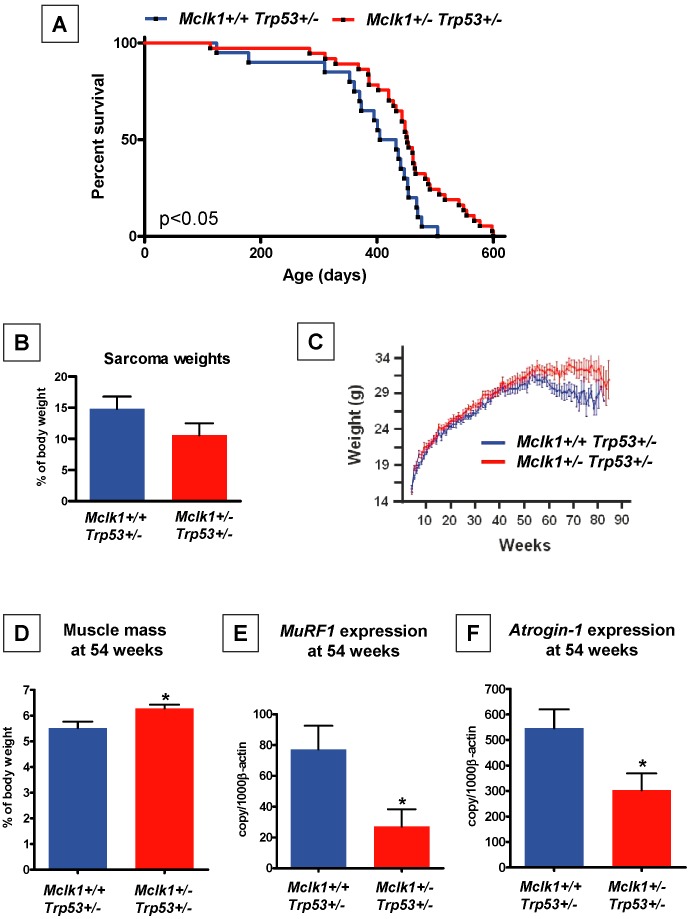
Indirect evidence for altered tumorigenesis in the Mclk1
+/− mutants.
A. Kaplan-Meier survival curves of Mclk1
+/+
Trp53
+/− (n = 20) and Mclk1
+/−
Trp53
+/− (n = 37) mice. The significance of the difference was P<0.05 by the log-rank (Mandel-Cox) test using GraphPad Prism Version 5.00 for Windows (GraphPad Software, San Diego). B. Weights of spontaneous sarcoma scored at necropsy of the animals in A., and expressed as percentage of body weight; Mclk1
+/+
Trp53
+/− (n = 9) and Mclk1
+/−
Trp53
+/− (n = 19). C. Body weights over time of the animals in A. D.-F. A cohort distinct from the animals in A. was analyzed for signs of cachexia; Mclk1
+/+
Trp53
+/− (n = 12) and Mclk1
+/−
Trp53
+/− (n = 8). All mice were humanely euthanized at 54 weeks of age. Hind limb muscle weight were measured and expressed as relative to body weight (D). The mRNA expression levels of two muscle specific E3 ubiquitin ligases, Atrogin-1 and MuRF1, were measured by RT-PCR, shown in (E) and (F), respectively. Significance for the aging curves was established by a log-rank test. The significance levels for the data in B. and D.-F. were tested by t-tests, with the asterisks standing for p<0.05. All experiments in this figure were carried out with females only.